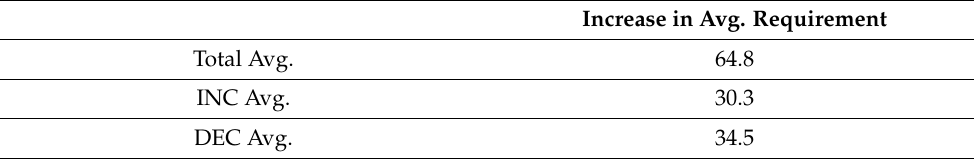
Table 15. RA Backup Model INC and DEC Predictions Compared to RA